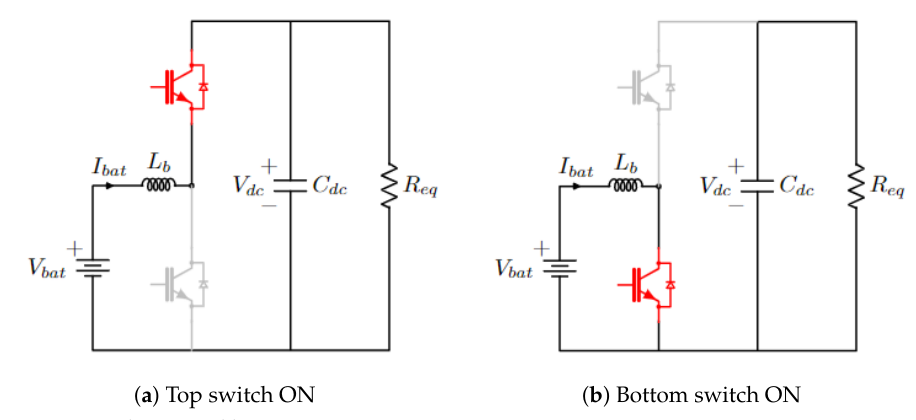
Figure 4. Bidirectional boost converter